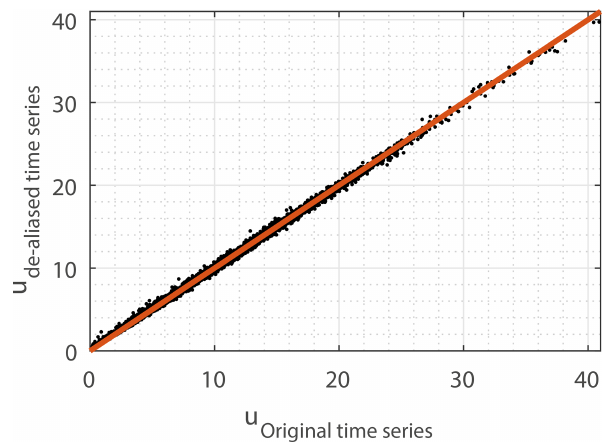
Figure A2. Scatterplot between WRF-generated wind speed time series at site C before ( x axis) and after ( y axis) de-aliasing of the time